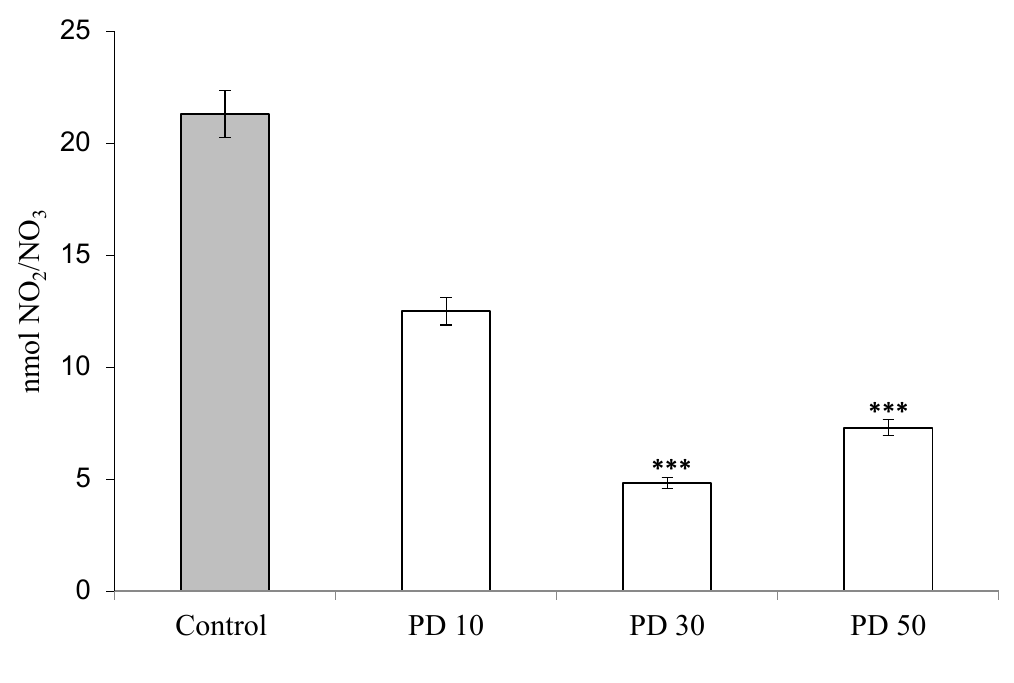
Figure 4. Effect of P. dermoporus polysaccharides on NO production from the pleural exudate of Wistar rats with carrageenan-induced pleurisy. The animals were treated with 10 mg/kg (PD 10), 30 mg/kg (PD 30) and 50 mg/kg (PD 50) of P. dermoporus extract. Control: Wistar rats with carrageenan-induced pleurisy. Data obtained from animal experiments ( n = 7) are expressed as the mean ± SD. The differences between the treatment and control were tested using ANOVA. A value of (***) p < 0.001 was considered statistically